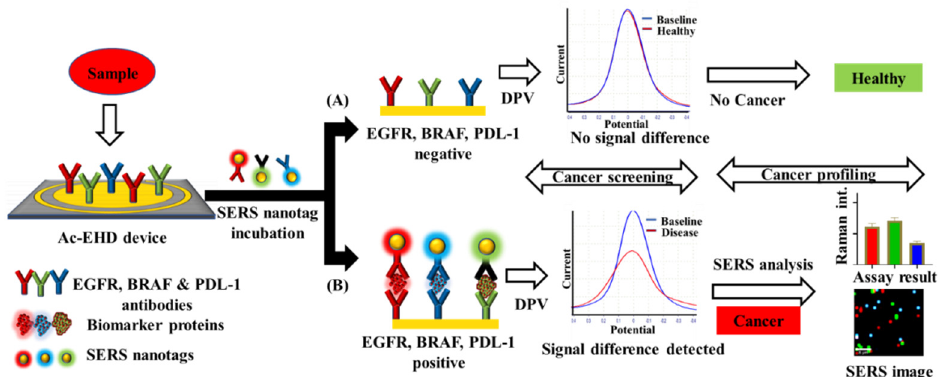
Figure 1. Schematic of the dual detection biosensor platform. The sample was added to the anti- EGFR, BRAF, and PDL-1 antibody functionalised biosensor. Screening of samples that are negative for circulating EGFR, BRAF, and PDL-1 follows scheme ( A ) where DPV signals remain similar before and after sample analysis. If the sample contains any of the three circulating proteins, the assay follows ( B ). The dual detection biosensor initially detects the presence the protein panel by a detectable DPV signal change. Subsequently, SERS mapping of the biomarker captured and SERS tag labelled surface is performed to read-out the individual protein expressions